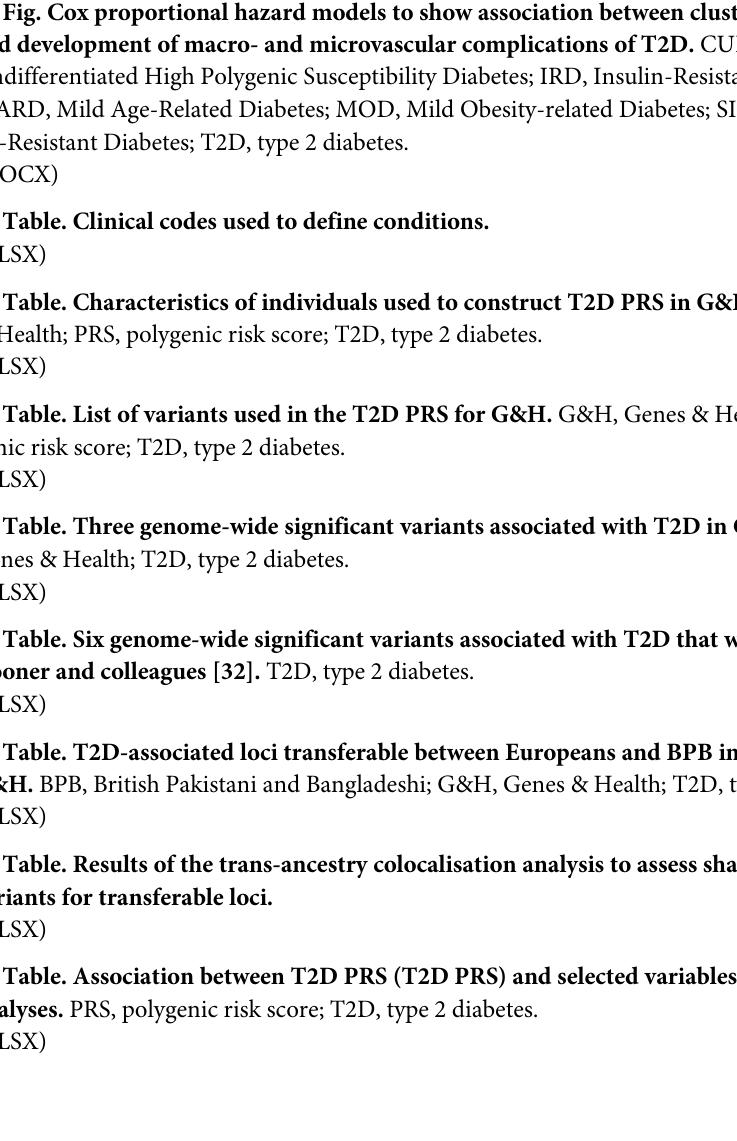
S6 Table. T2D-associated loci transferable between Europeans and BPB individuals in G&H. BPB, British Pakistani and Bangladeshi; G&H, Genes & Health; T2D, type 2 diabetes. S7 Table. Results of the trans-ancestry colocalisation analysis to assess sharing of causal variants for transferable loci. S8 Table. Association between T2D PRS (T2D PRS) and selected variables included in analyses. PRS, polygenic risk score; T2D, type 2